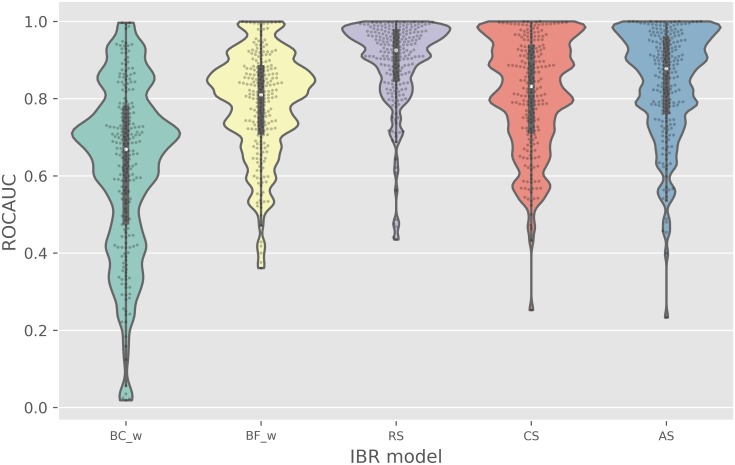
A comparison of models with respect to compound ranking performance as assessed by ROCAUC values.Each model was evaluated on 224 targets through PKIS1 leave-one-target-out validation. ROCAUC of 0.5 indicates a random ranking of compounds on a given target; ROCAUC of 1.0 represents ideal ranking with all active compounds prioritized above the inactives. The individual target evaluations are shown as light grey dots with median and interquartile ranges displayed as a white circle and black bars, respectively.